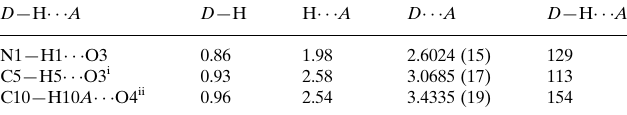
Hydrogen-bond geometry (A˚ , (cid:2)